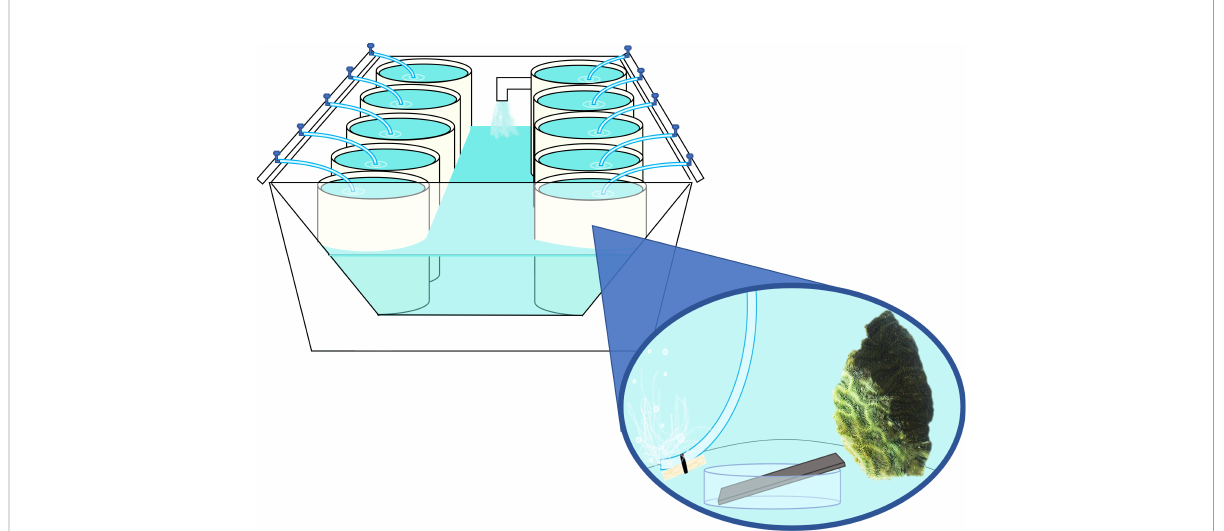
FIGURE 1 Mock-up of mesocosm water table, exemplifying arrangement of individual coral mesocosms. Each water table contained ~ 570 L of recirculating, temperature-controlled freshwater. Separate water tables were used to hold diseased and healthy coral mesocosms to reduce cross-contamination. Superimposed image depicts individual mesocosm setup, with each mesocosm containing ~18L of fi ltered and UV-treated seawater (FSW), a “ donor ” coral, a weighted airline for aeration and water circulation, and a stainless steel plate arranged on a sterile petri dish to allow for water contact on all